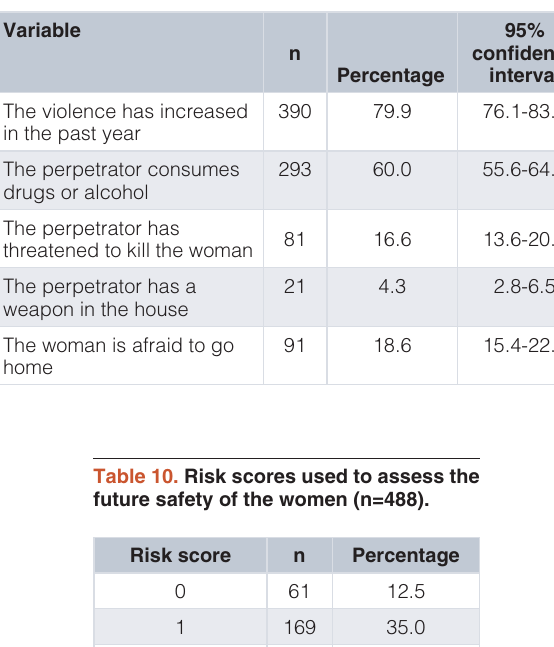
Table 9. Assessment of safety